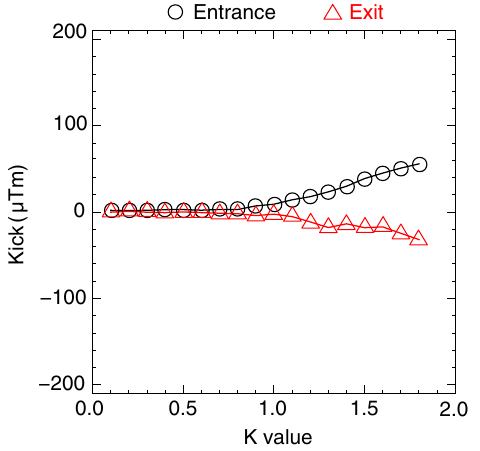
FIG. 67. Undulator entrance (black circles) and exit (red triangles) kicks measured as a function of the undulator K value in the horizontal plane.